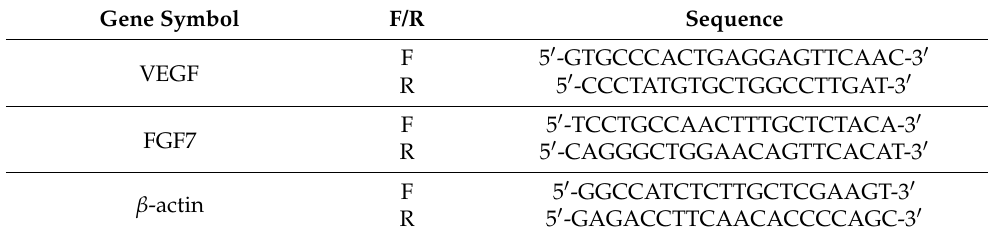
Table 2. Primer information for efficacy validation in vitro.